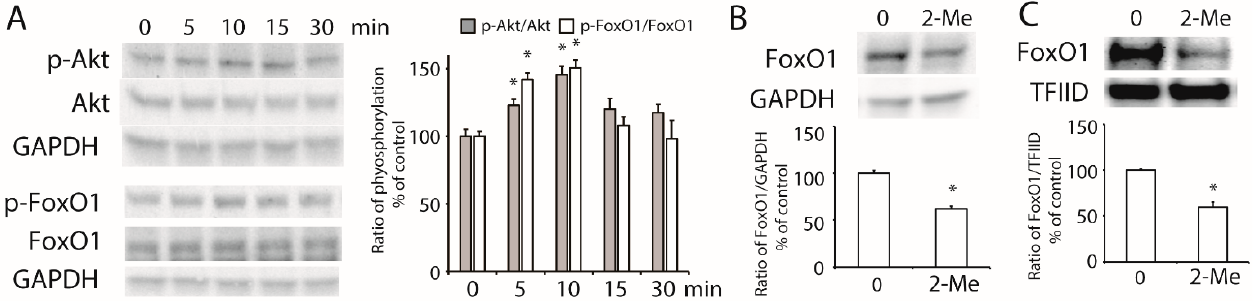
Figure 4. Activation of Akt and FoxO1 induced by 2-ME2. ( A ) 2-ME 2 stimulated the phosphorylation of Akt at the Ser473 site and FoxO1 at the Ser256 site. A histogram shows the mean ± SEM ( n = 3) of phosphorylation for each group. ( B ) Effect of 2-ME 2 on the expression of FoxO1. ( C ) Nuclear abundance of FoxO1 in HepG2 cells treated with 2-ME 2 . Abundance of GAPDH or TFIID served as the control. A histogram shows the mean ± SEM ( n = 3) of separate experiments for each group. * p < 0.05 compared to